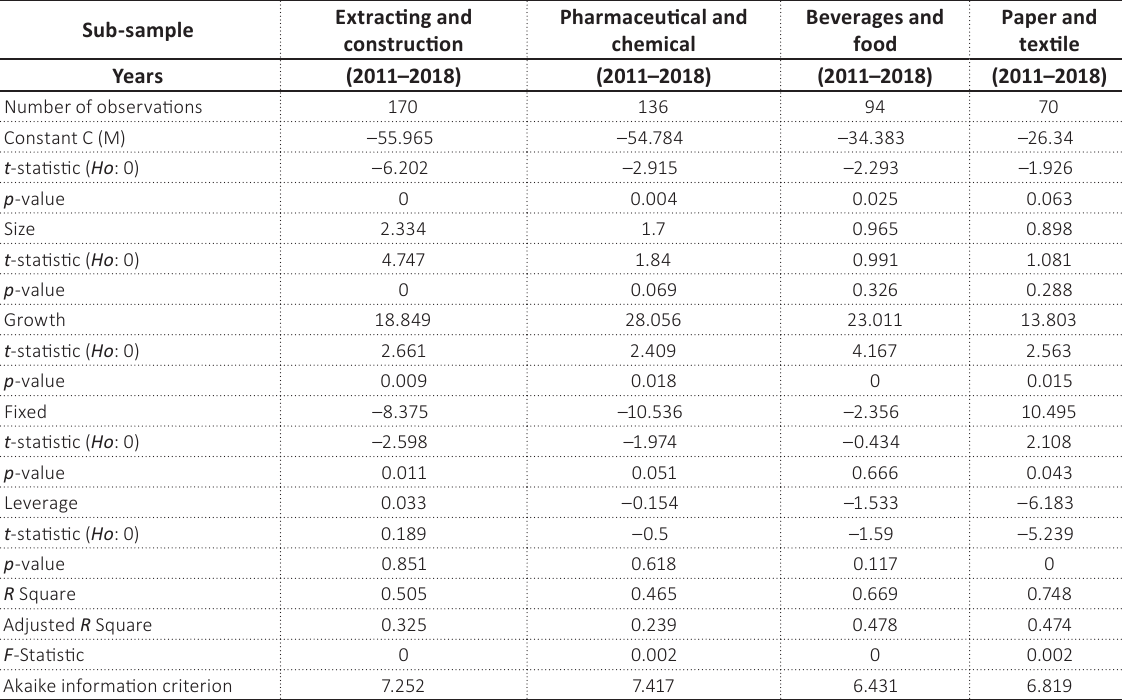
Table 8 gives the regression analysis results for the industrial sector sub-samples. Table 8. Regression analysis for the industrial sector